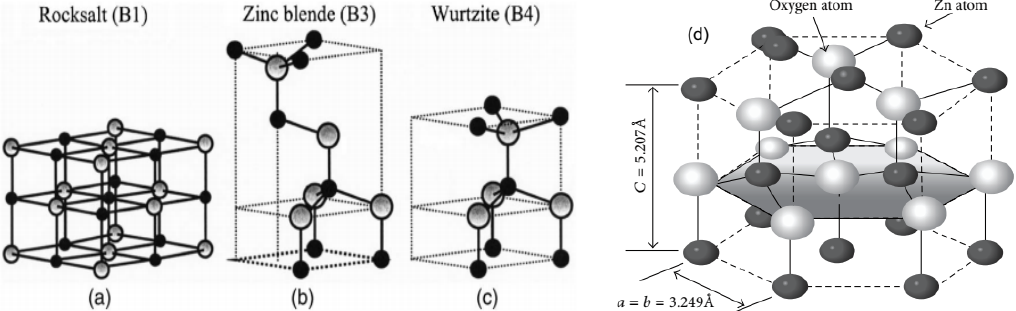
Figure 2. Structures shared by ZnO: ( a ) rock salt, B1; ( b ) zinc blende, B3; and ( c ) wurtzite, B4 ( d ) tetrahedral ZnO. The shaded grey and black balls represent O and Zn atoms, respectively [114].